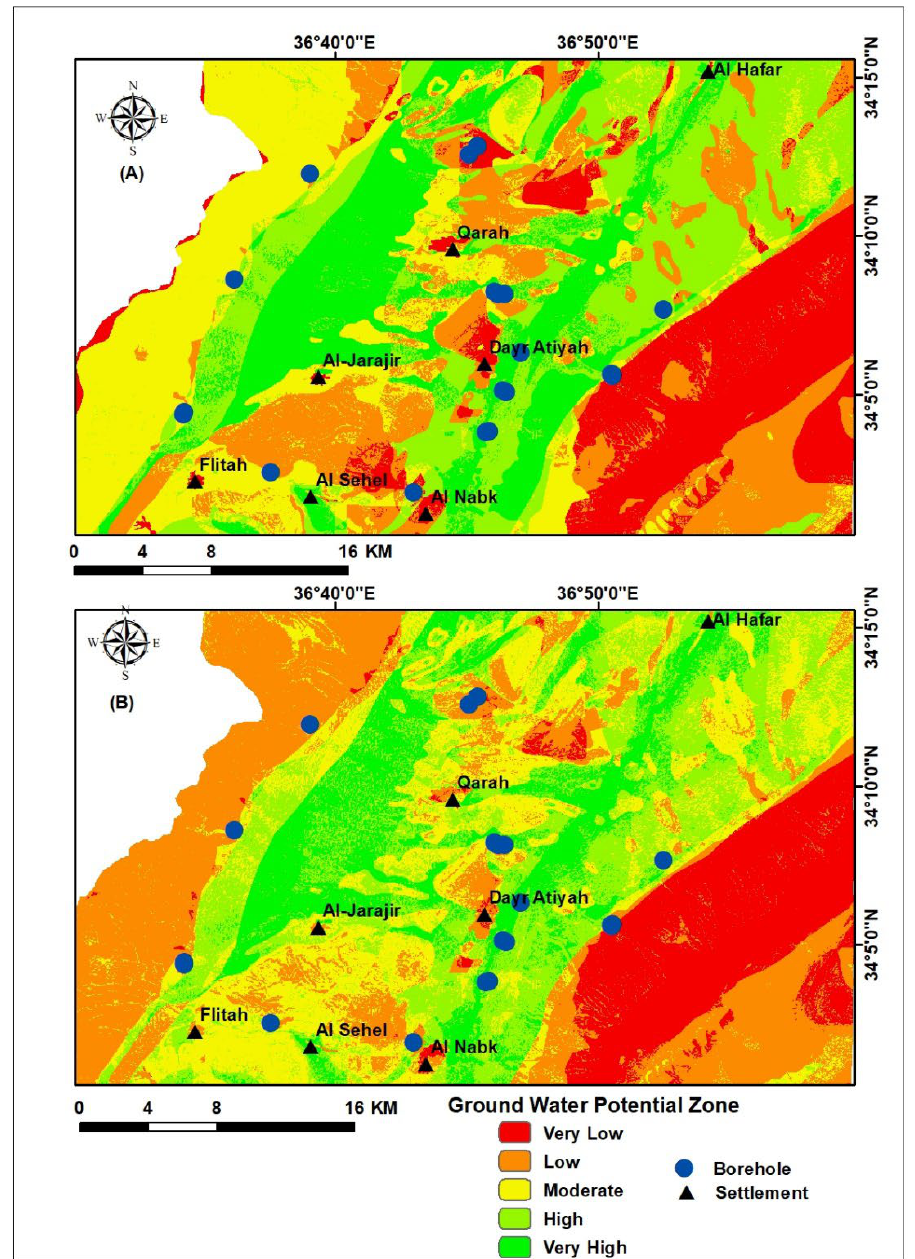
Figure A5. Groundwater Potential Zone of the ( A ) AHP5 and ( B ) MIF5 maps.